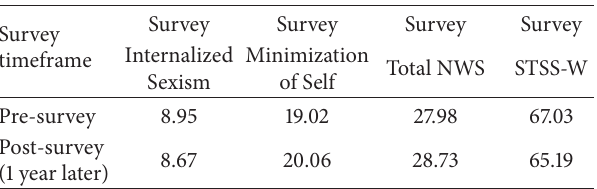
Table 4: Internalized Sexism, Minimization of Self, Total NWS, and STSS-W.